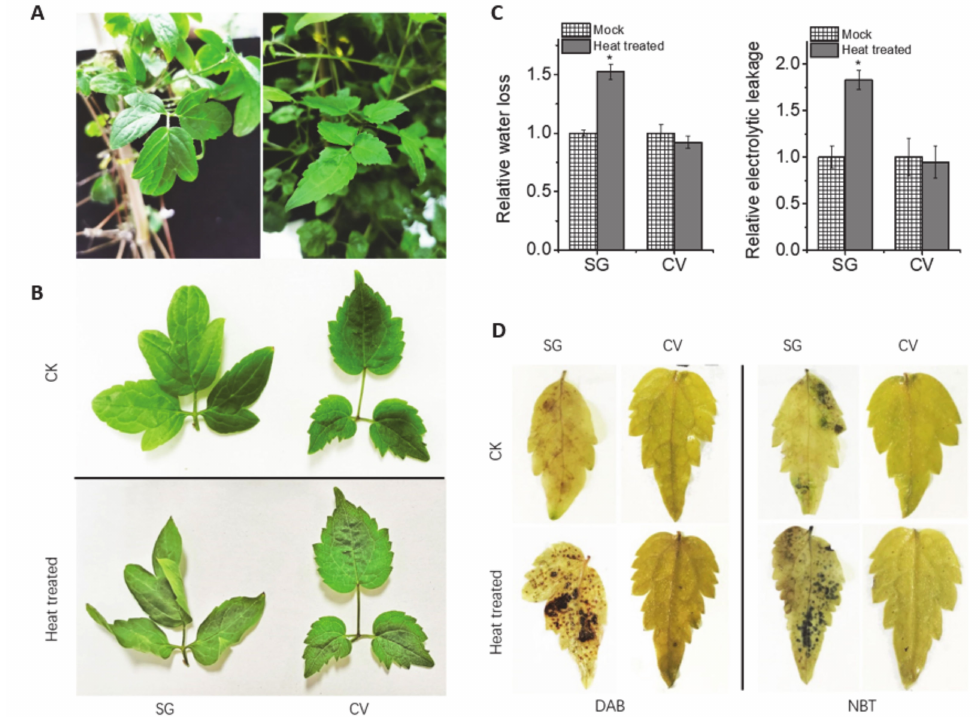
Figure 1. Two Clematis varieties and physiological changes after high-temperature treatment. ( A ) Two Clematis plants: Clematis vitalba (Cv, left) and Clematis “Stolwijk Gold” (SG, right). ( B ) Phenotype of the two Clematis plants after heat treatment. ( C ) Change of relative water loss and relative electrolytic leakage after high-temperature treatment (42 ◦ C for 2 h) in Clematis varieties. ( D ) Diaminobenzidine (DAB) and nitro blue tetrazolium (NBT) staining of the two Clematis varieties’ leaves after high-temperature treatment (42 ◦ C for 2